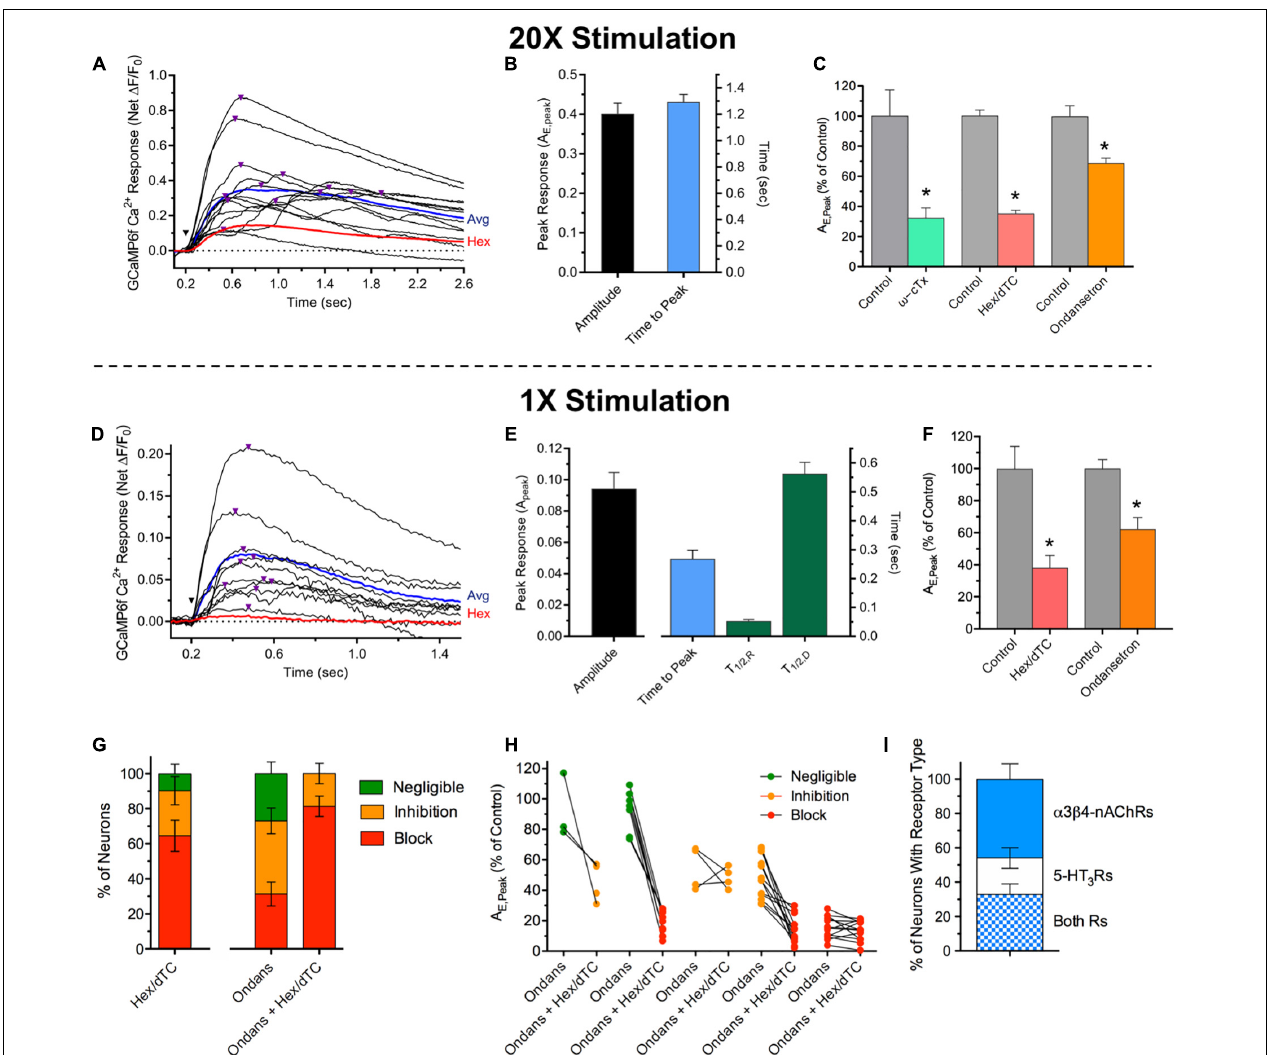
FIGURE 4 | Ca 2 + responses evoked by MG connective stimulation depend on presynaptic voltage-gated Ca 2 + channel activity and activation of postsynaptic nAChRs or/and 5-HT 3 Rs. (A) Time course of Ca 2 + fluorescence changes in 13 neuron somas (black traces) evoked by a train of 20 stimuli (1500 µ A, 10 Hz; 20 × stimulation) delivered at the inverted black triangle. Purple triangles above the traces depict the timing of peak responses (A E , Peak ). The response average from these neurons and that of the same neurons after incubation with Hex (100 µ M, 15 min) are depicted by the blue and red traces, respectively. (B) Summary of responses to 20 × stimulation. 20 × stimulation evoked an average peak responses of A E , peak = 0.41 ± 0.02 with an average time to peak response of 1.29 ± 0.06 s ( n = 175, N = 4). (C) 20 × response pharmacology. A E , peak values for neurons treated with antagonists are presented relative to those obtained from the same neurons assayed before incubation in drug. Treatment with ω -CTx (0.1–0.2 µ M; 60 min) to block presynaptic voltage-gated Ca 2 + channels (green bar), Hex/dTC (100 µ M each; 15 min) to block nAChRs (salmon bar), or Ondansetron (20 µ M; 15 min) to block 5-HT 3 Rs (orange bar) significantly reduced A E , Peak to levels that were 32 ± 7, 35 ± 3, or 68 ± 4%, respectively, of those obtained from the same neurons assessed before antagonist application (gray bars, Control; p < 0.05 for each). For ω -CTx, Hex, and Ondansetron the corresponding replicates were n = 15, 168, and 196 and N = 1, 4, and 3. (D) Time course of Ca 2 + fluorescence changes in nine neuron somas (black traces) evoked by a single 1500 µ A stimulus (1 × stimulation) delivered at the inverted black triangle. Purple triangles above the traces depict the timing of peak responses (A E , Peak ). The response average from these neurons and that of the same neurons after incubation with Hex (100 µ M; 15 min) are depicted by the blue and red traces, respectively. (E) Summary of responses to 1 × stimulation. Left: A E , Peak values obtained in response to 1 × stimulation (0.091 ± 0.013, n = 42; N = 2) were indistinguishable from those associated with spontaneous Ca 2 + transients ( Figure 2 ; p > 0.05). Right : The latency to A E , Peak was 0.268 ± 0.031 s ( n = 42; N = 2). The responses to 1 × stimulation displayed rise and decay time kinetic parameters (T R , 1 / 2 = 0.053 ± 0.005 s and T D , 1 / 2 = 0.563 ± 0.039 s; n = 30; N = 2) values not significantly different from those for the spontaneous Ca 2 + transients ( Figure 2 ; p > 0.05). (F) Pharmacology. Treatment with Hex or Hex/dTC (Hex/dTC, 100 µ M each; 15 min) to block nAChRs (salmon bar) significantly reduced A E , Peak to 38 ± 8% ( n = 31; N = 2) while application of Ondansetron to block 5-HT 3 Rs reduced A E , Peak to 62 ± 7% ( n = 48; N = 3) both relative to the same neurons assessed before antagonist application (gray bars, Control). (G) Differential effects of antagonists on A E , Peak responses in subsets of MG neurons. Antagonist effects on Ca 2 + responses to 1 × stimulation between treated and control neuron pairs were subdivided as block ( ≥ 70% reduction of A E , Peak , red) inhibition (69–30% reduction, orange) or negligible ( ≤ 29% reduction, green) and expressed as the per cent of neurons in each category ( n = 48, N = 3). Left: effect of Hex/dTC. Middle and right: effect of Ondansetron, followed in the same cells by Ondansetron and Hex/dTC. (H) Transition of individual neurons in (G) that were unaffected (green) or inhibited (orange) by Ondansetron, to inhibited or blocked (red) following treatment with Ondansetron and Hex/dTC. Note that some neurons inhibited or blocked by Ondansetron remained so